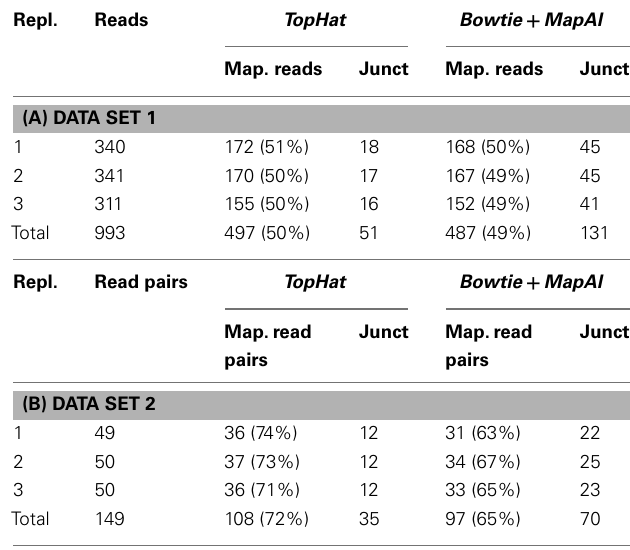
Table 1 | Statistics of reads and mapping results.